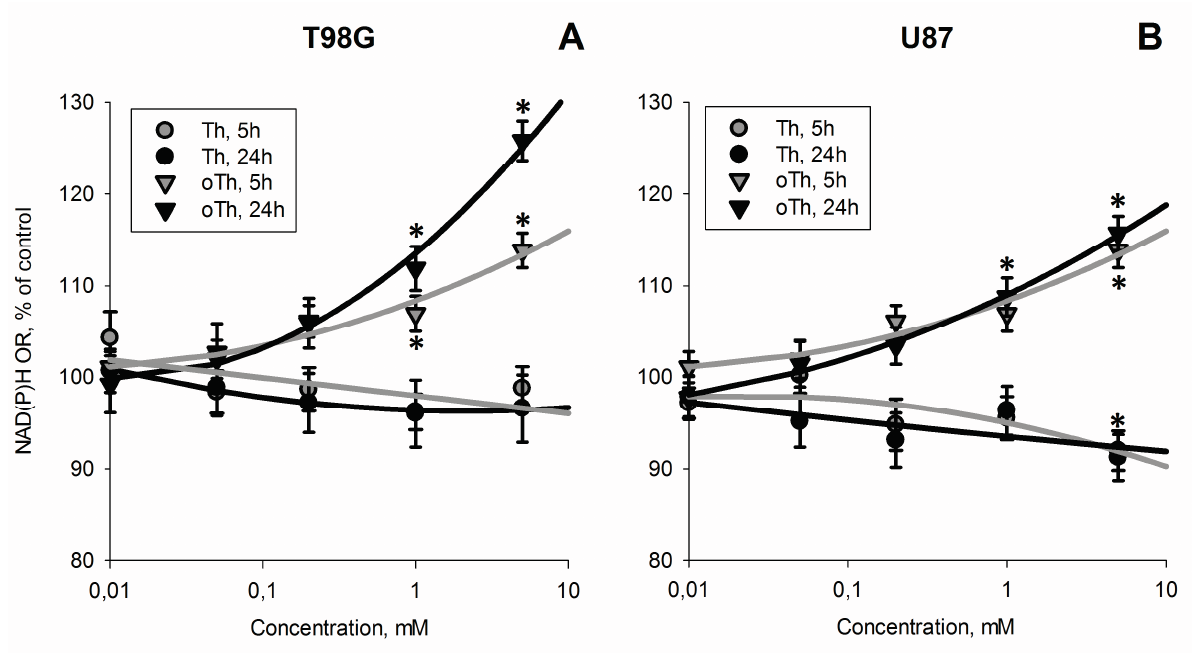
Figure 1. Concentration- and time-dependent changes of NAD(P)H:resazurin oxidoreductase activity (NAD(P)H OR) of T98G ( A ) and U87 ( B ) cells incubated with different concentrations of thiamin (Th) or oxythiamin (oTh). Incubation time (5 h or 24 h) is indicated on the graphs. Changes relative to the control values are presented as mean ± SEM, %. Significant differences with control (* p < 0.05) were determined by one-way ANOVA followed by post-hoc analysis using Dunnett’s Multiple Comparison